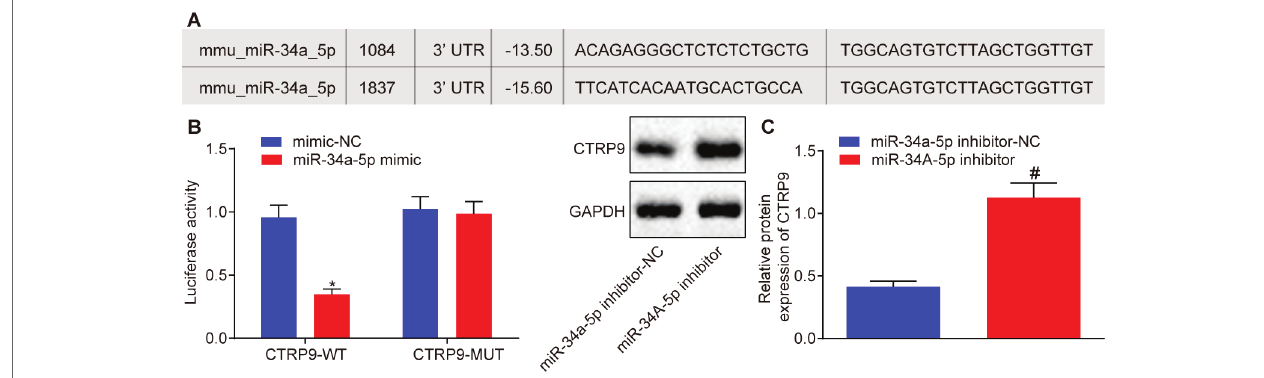
FIGURE 1 | CTRP9 is a target gene of miR-34a-5p. (A) Predicted binding sites between miR-34a-5p and 3 ′ UTR of CTRP9. (B) Luciferase activity detected using the dual-luciferase reporter gene assay. * p < 0.05 vs. the mimic-NC group. (C) The effect of miR-34A-5p inhibitor on CTRP9 expression detected by western blot analysis. # p < 0.05 vs. the miR-34a-5p inhibitor-NC group. Data (mean ± s.d.) between two groups were analyzed by the unpaired t -test. The experiment was repeated three times. CTRP9, C1q/tumor necrosis factor-related protein-9; miR-34a-5p, microRNA-34a-5p; WT, wild type; MUT, mutant type; 3 ′ UTR, 3 ′ untranslated region; NC, negative control; s.d., standard